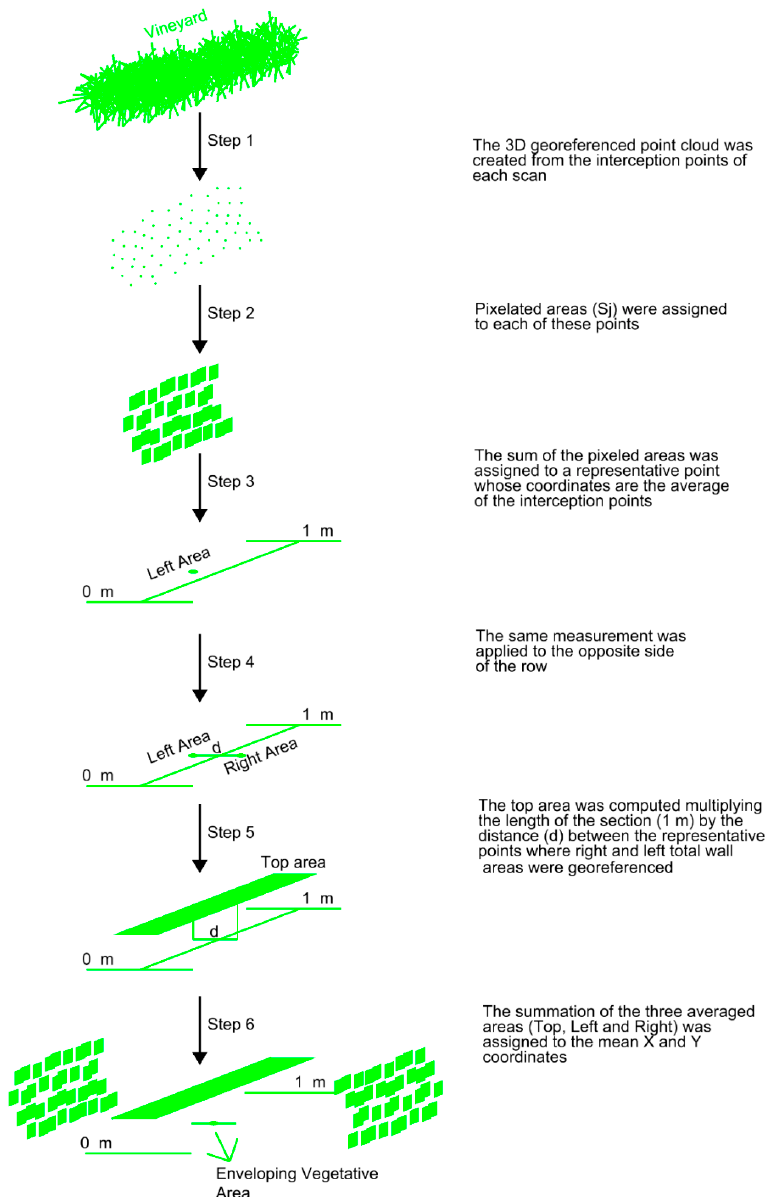
Figure 5. Diagram of data processing to compute the envelope vegetative area of the 1-m length section.